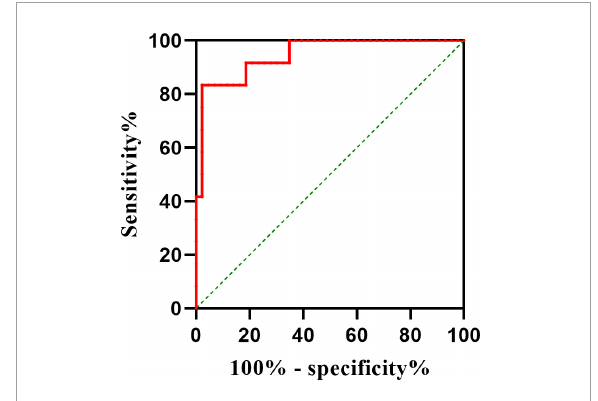
FIGURE4 Value of plasma CGRP in predicting the therapeutic efficacy of midodrine hydrochloride in children with VVS. The y-axis represents the sensitivity of the CGRP for predicting the effectiveness of midodrine hydrochloride therapy. The x-axis represents the false positive rate (1-specificity) of the prediction. The intermittent green line indicates the point at which the sensitivity is equal to false positive rate (i.e., no predictive value). The red line represents the ROC curve (AUC 94.6%, 95% CI 87.9–99.7%) indicating that pre-treatment plasma CGRP levels have a high predictive value in assessing the efficacy of midodrine hydrochloride in patients with VVS. CGRP, calcitonin gene-related peptide; VVS, vasovagal syncope; ROC, receiver-operating characteristic curve; AUC, area under